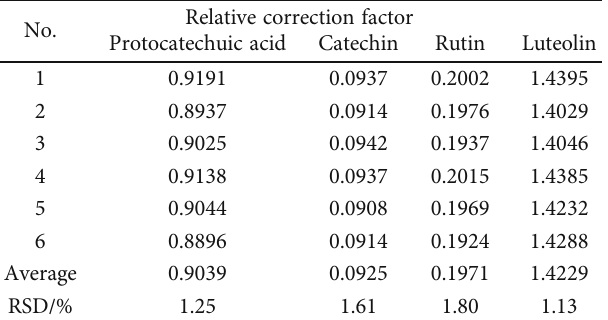
Table 4: Relative correction factors of various constituents.